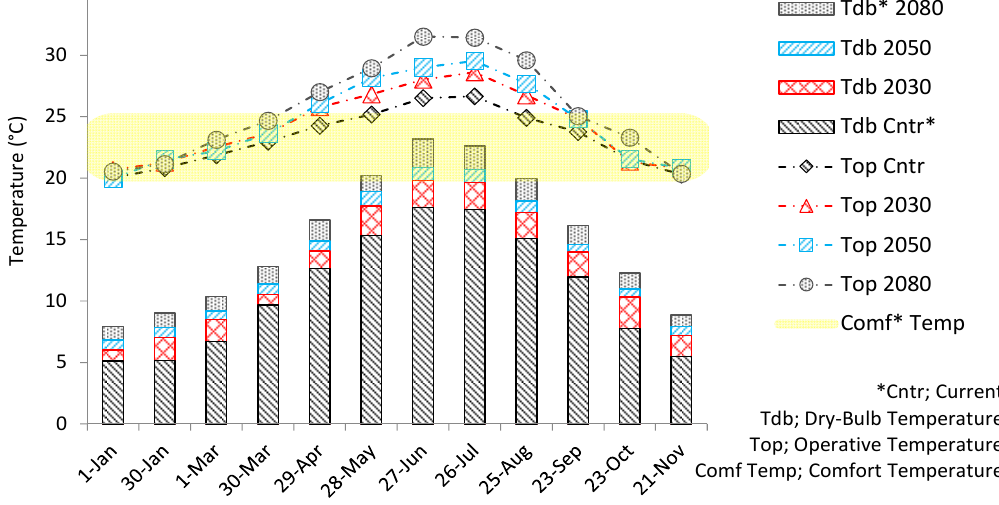
Figure 4. Monthly outdoor dry bulb air and average indoor operative temperature (°C) in the pilot study unit for current and future weather conditions